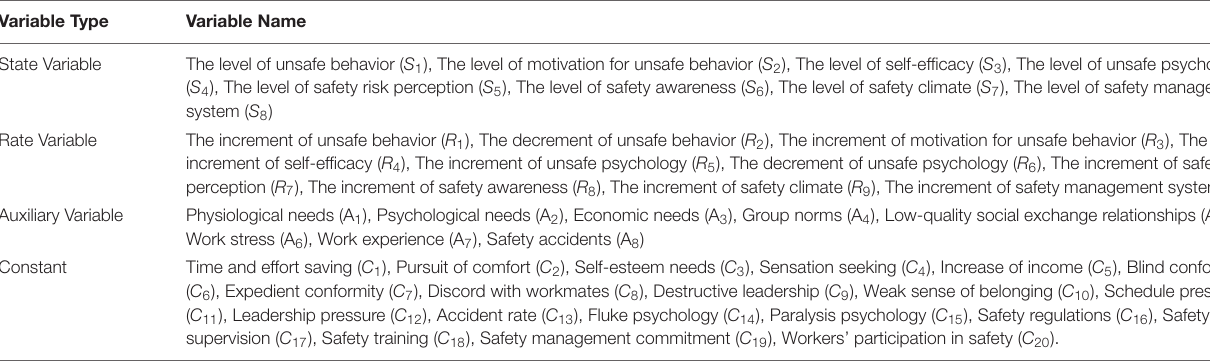
FIGURE 3 | The stock flow diagram. TABLE 5 | Variable names and